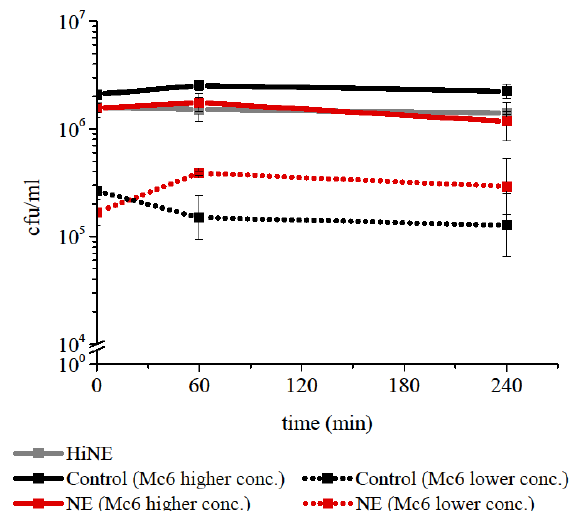
Figure 1. Neutrophil elastase (NE) does not have bacteriolytic activity against M. catarrhalis . Bacteria from log phase were incubated for 4 h in the presence of 2 µ M of NE and plated in 0, 60, and 240 min. Data are expressed as meancfu/mL ± SD from at least two independent experiments performed in triplicate. HiNE—heat inactivated NE (95 ◦ C, 15